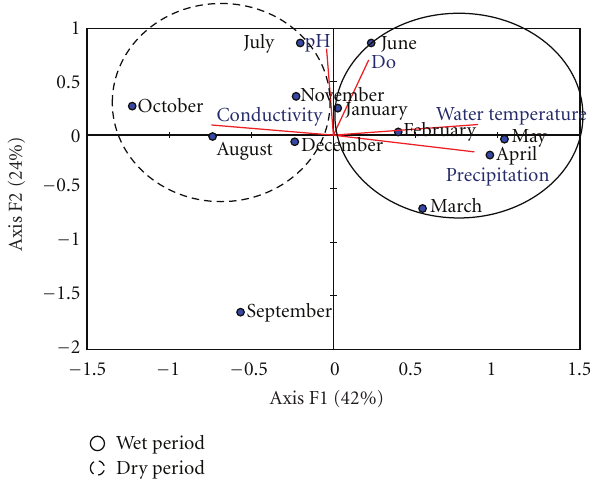
Figure 7: Principal component analysis of limnological variables during the rainy and dry